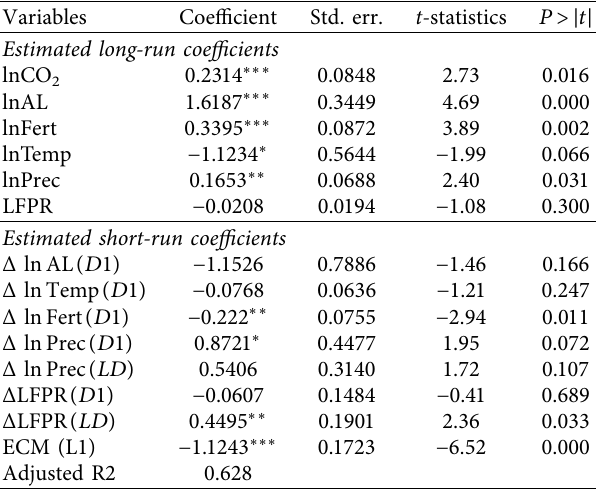
Table 5: The estimated results of the ARDL model (long- and short-run